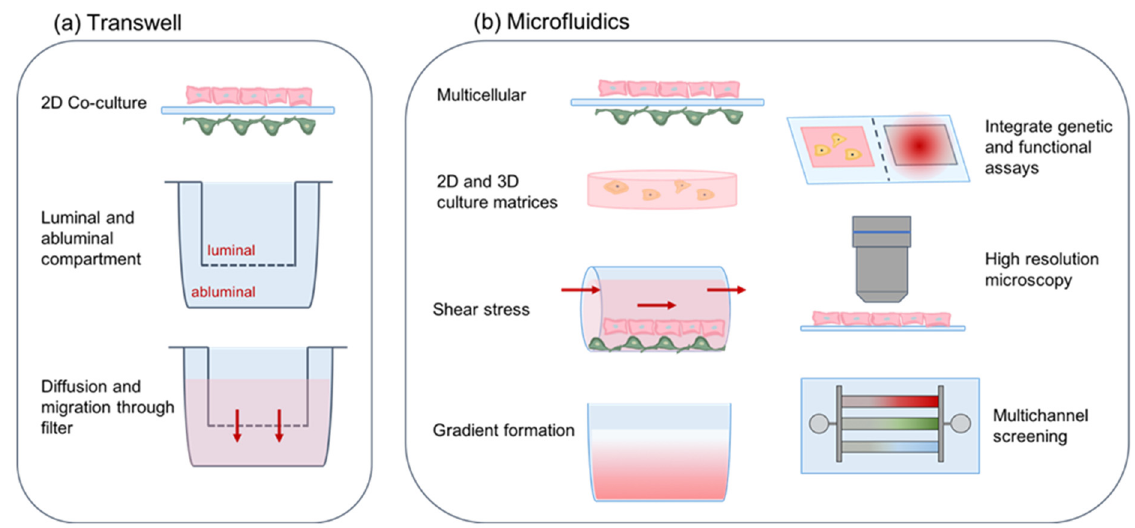
Figure 7. Properties of BBB in vitro models. ( a ) Transwell systems utilize a porous filter insert that divides culture wells into luminal and abluminal compartments and allows for diffusion of molecules and cell migration across the filter. ( b ) Microfluidic devices recapitulate a more complex tissue environment in vitro by co-culturing cells in 2D and 3D matrices. Parameters including shear stress and gradient formation are tunable to establish a controlled microenvironment. Microfluidics enable integration of sensing systems and high-resolution microscopy. Multichannel designs allow samples to be screened in parallel, creating compact medium-throughput systems for simulating biological conditions and enabling drug screening. Brain EC are shown in pink on the luminal side, and brain pericytes are marked in green on the abluminal side.